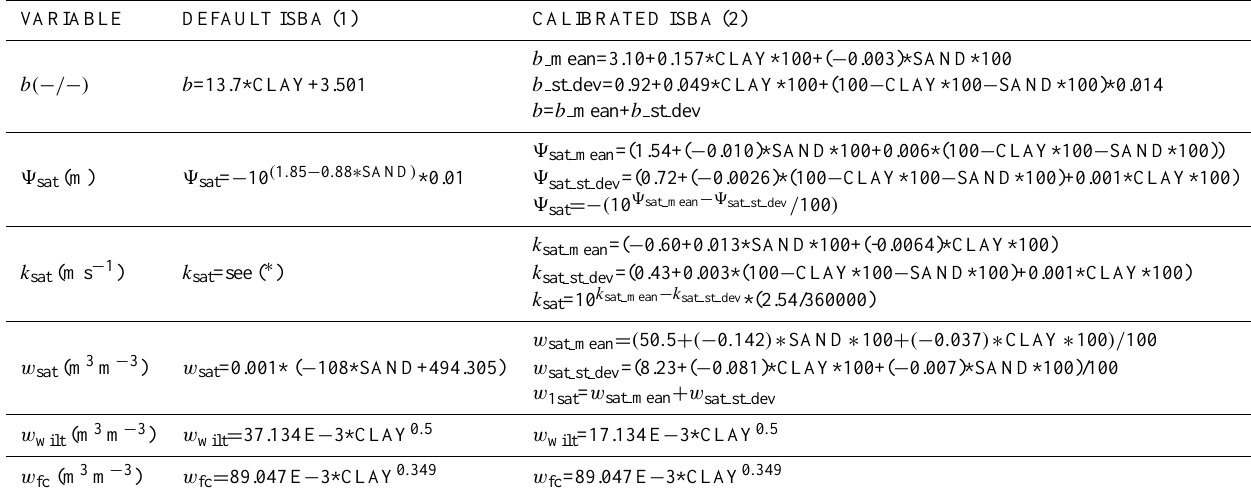
Table 2. Equation of hydrological parameters used in default (DEFAULT ISBA (1) see Giordani, 1993; Noilhan and Lacarr`ere, 1995) and calibrated (CALIBRATED ISBA (2) see Cosby et al. (1984) and Boone et al., 1999) version of